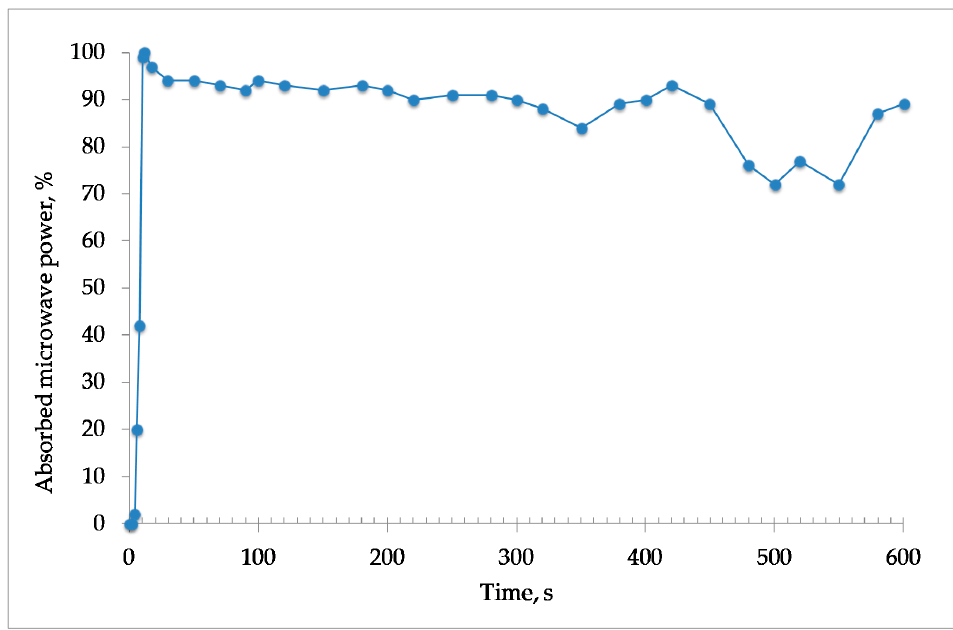
Figure 9. Percentage of the absorbed power from BR, mixed with metallurgical coke (C/BR 0.180) at 0.6 kW, 1 L/min N 2 flow constant for 600 s.